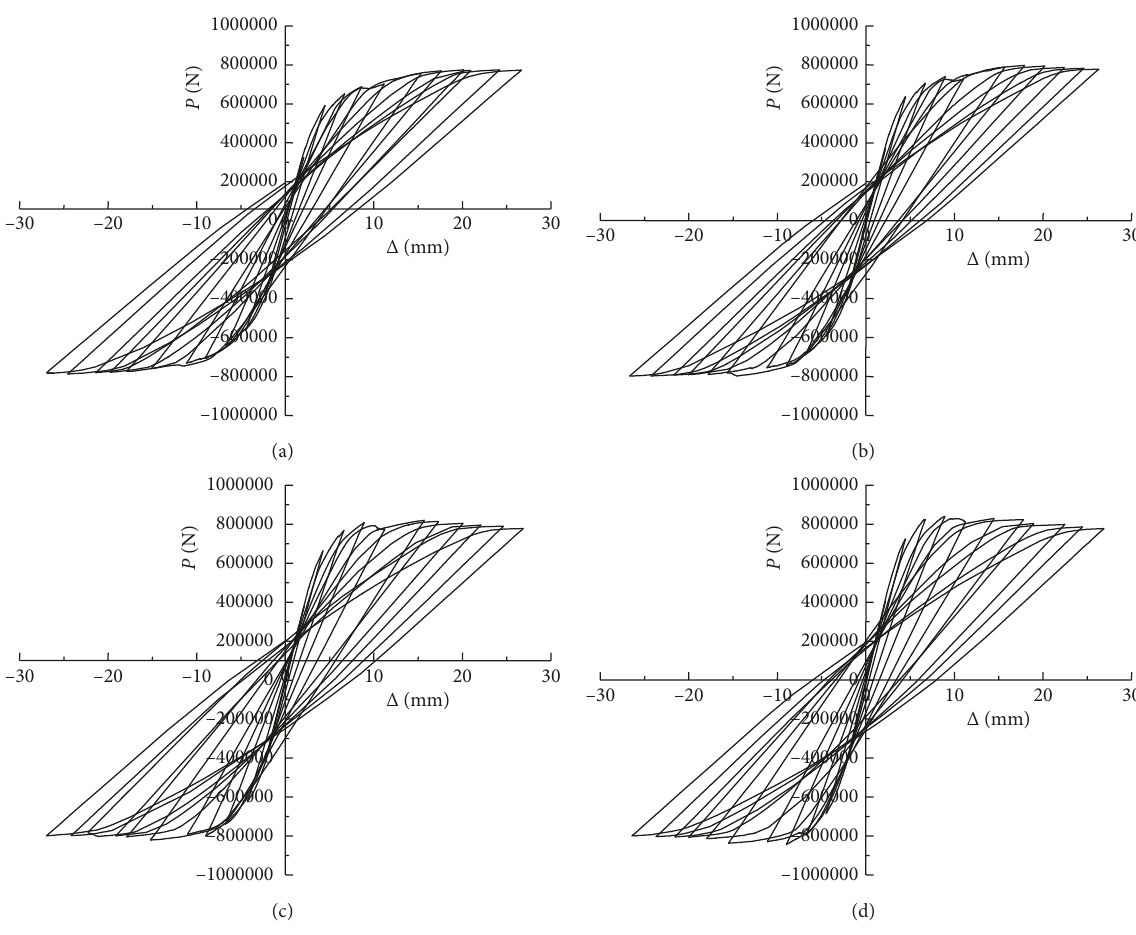
Figure 6: Hysteresis curves of frames with various concrete strength levels. (a) K-1. (b) K-2. (c) K-3. (d) K-4.